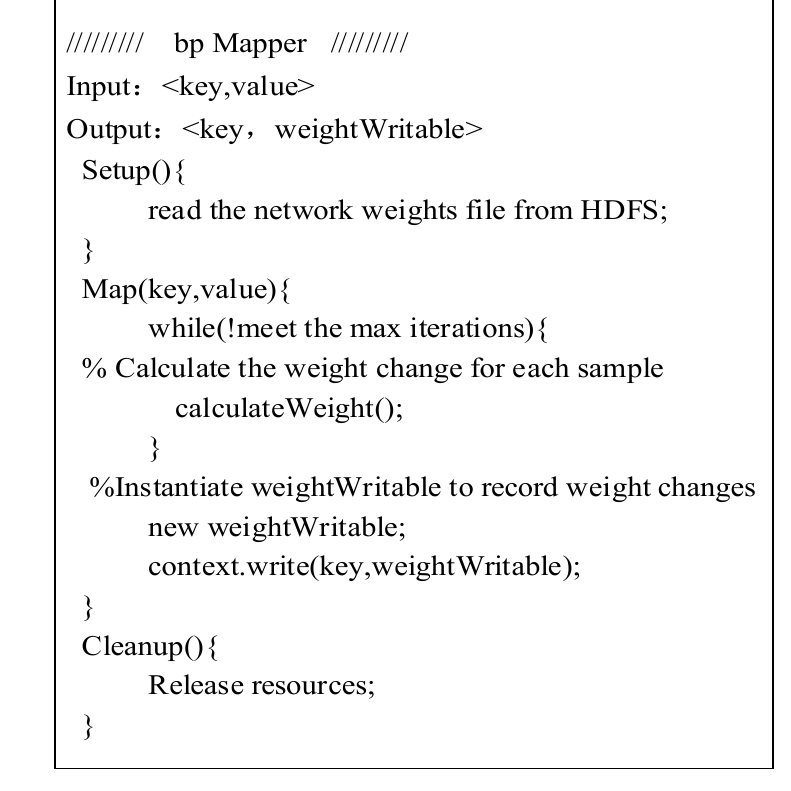
Figure 10. The pseudo code of Map stage.